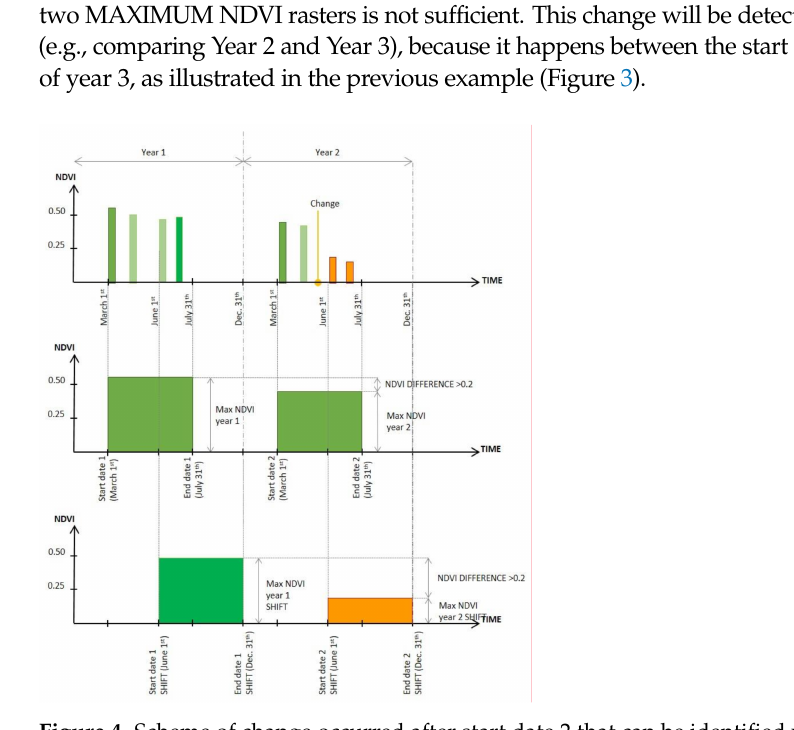
Figure 4. Scheme of change occurred after start date 2 that can be identified with the shift